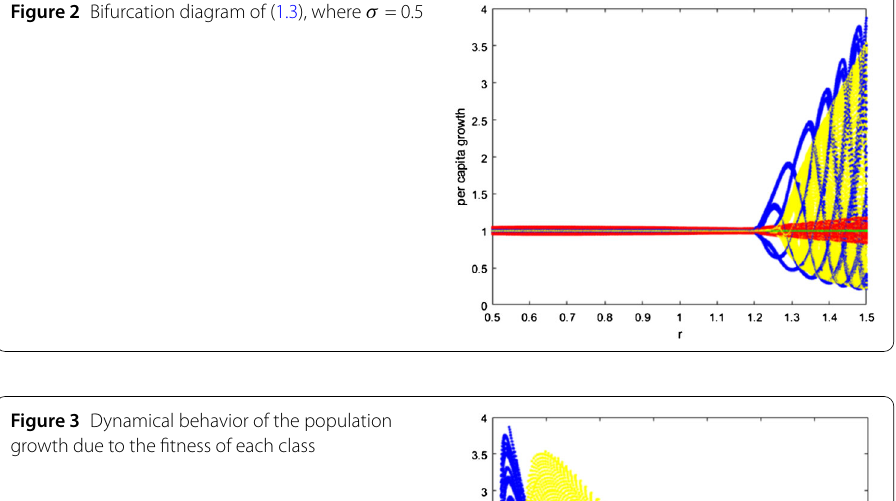
Figure 3 Dynamical behavior of the population growth due to the fitness of each class